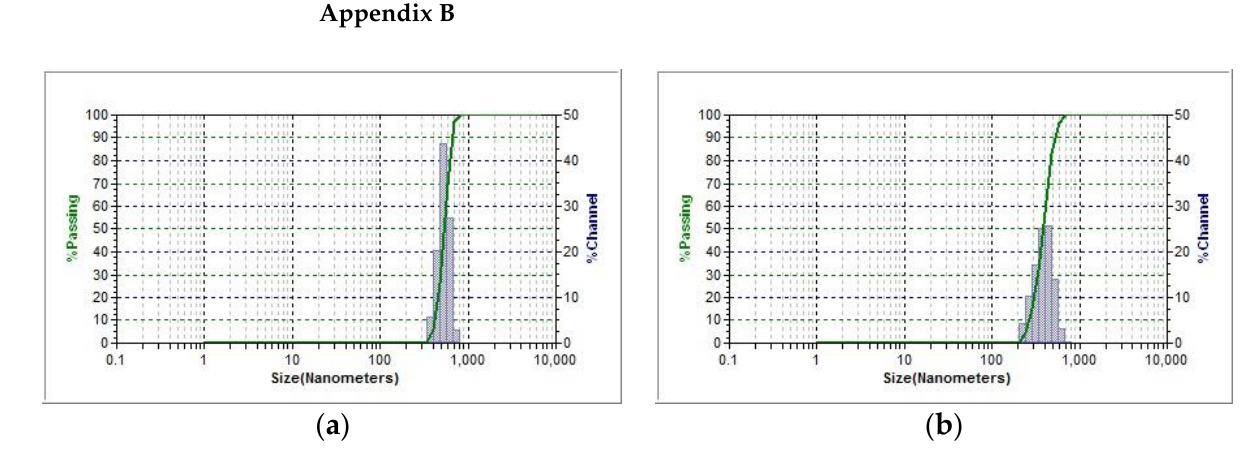
Figure A1. Original histograms of number-weighted size distribution of macromolecular associates of ( a ) N-2-hydroxy-3- (hexadecyl) methyl chitosan (Ch1-L-C16-3s sample, degree of substitution of 0.012) and ( b ) initial chitosan with degree of acetylation of 0.07 and Mw of 140 kDa (Ch2-LMw sample) in 0.2 wt-% solutions in aqueous acetic